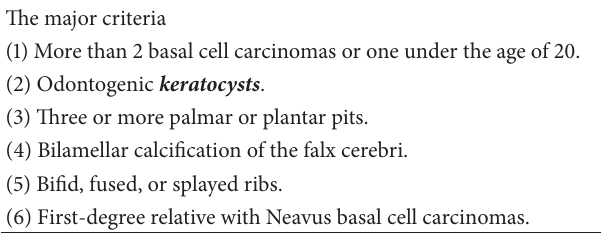
Table 1: Diagnostic criteria for Goling-Goltz